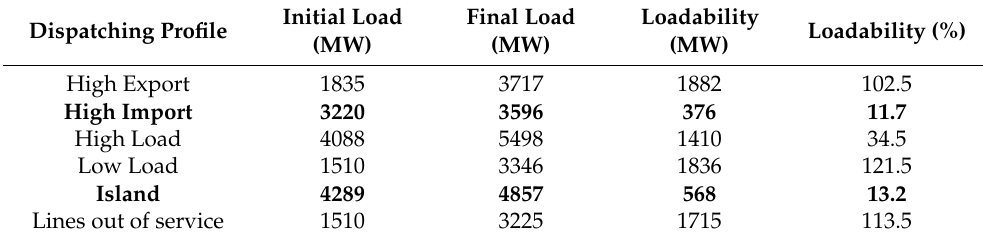
Table 20. Loadability margins for the selected DPs.